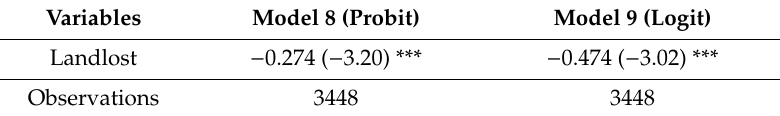
Table 5. Robustness of estimating health status: the alternative measures.